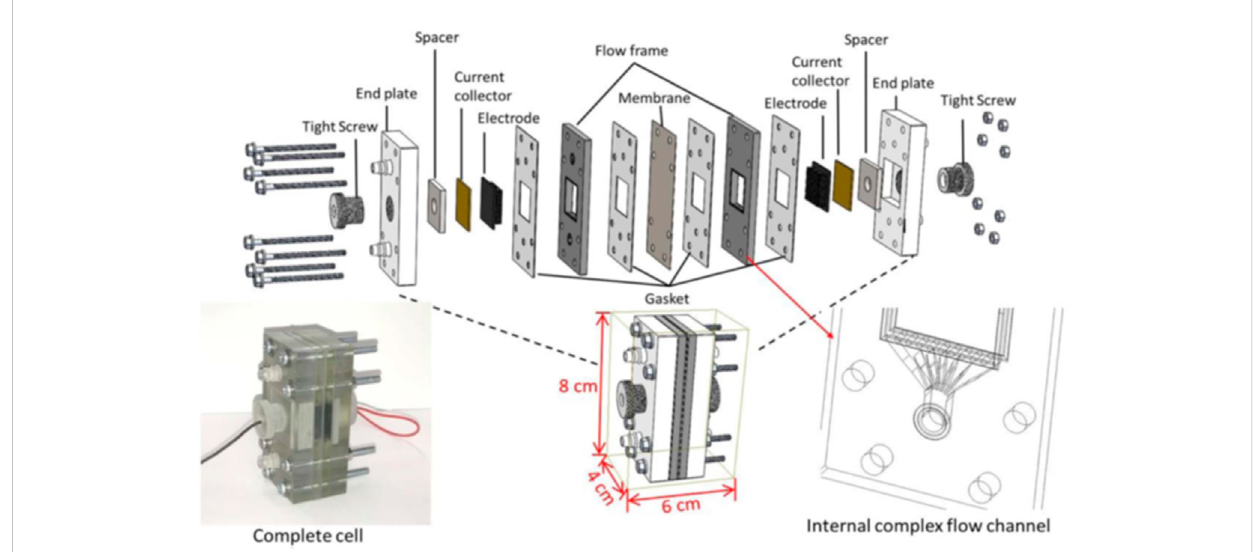
FIGURE 2 Structure and assembly miniature of a VRFB prototype, Reproduced under CC-BY-4.0 from Sun et al. (2019).